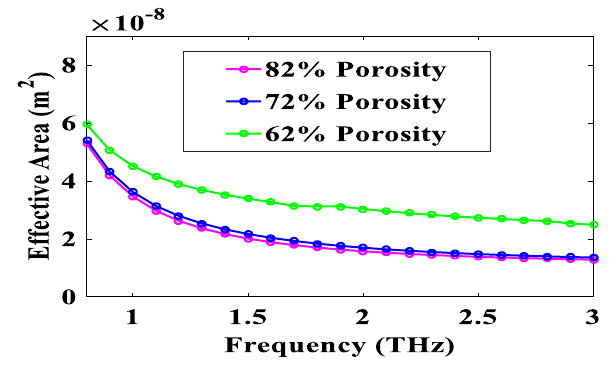
Fig. 3 Effective Area of H-PCF versus Frequency at 82%, 72% and 62% porosity levels